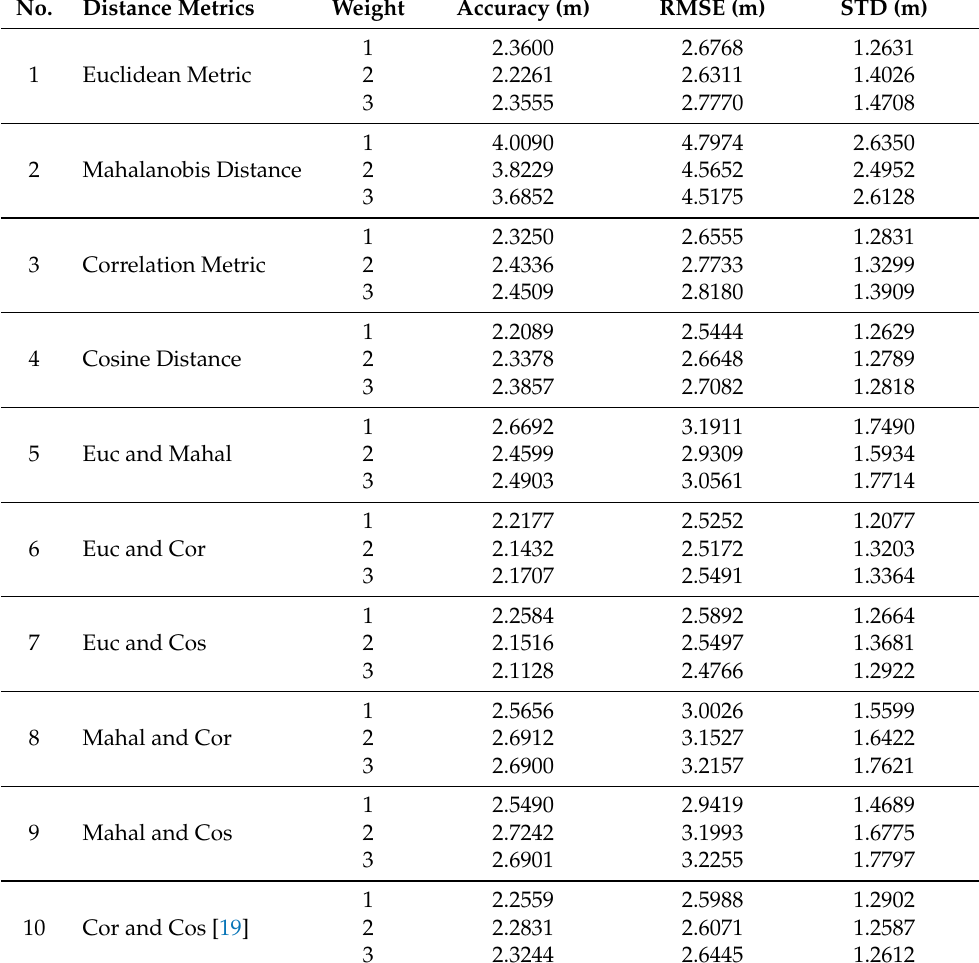
Table 3. The performance comparison 1 of different distance metrics and weight